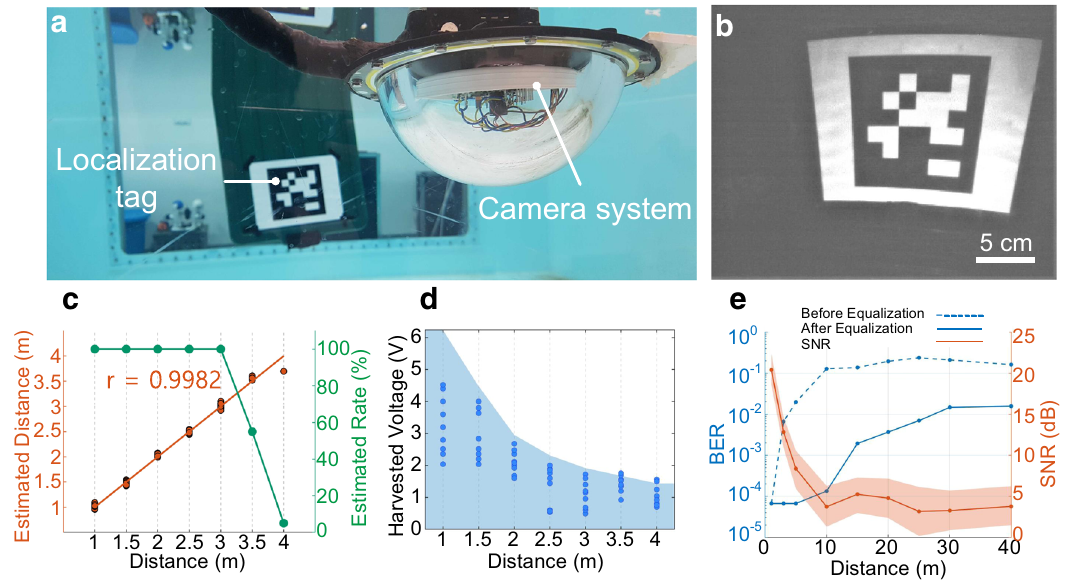
Fig. 4 | Captured images of AprilTag markers demonstrate successful under- waterinferenceandlocalization.a Theprototypewasusedtodetectandlocalize submerged localization tags. b An image of the AprilTag obtained using a bat- teryless prototype. c The estimated location of the AprilTag is plotted in red as a functionofitsactuallocation,andthedetectionrateofAprilTagisplottedingreen as a function of distance. d Harvested voltage is plotted as a function of distance between the transmitter and the batteryless camera prototype. The dots indicate